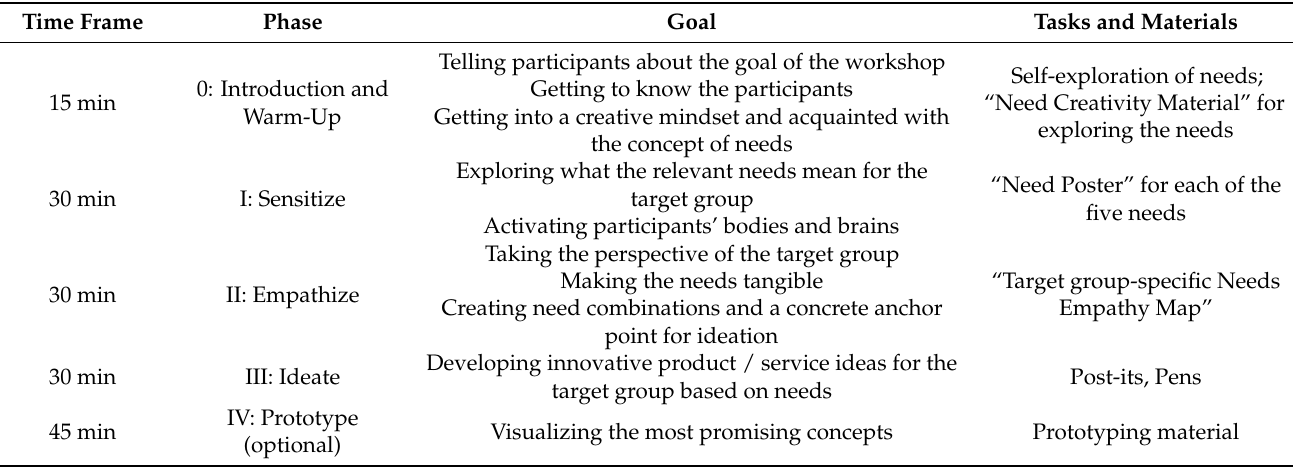
Table 8. Phases of the Need-based Creativity